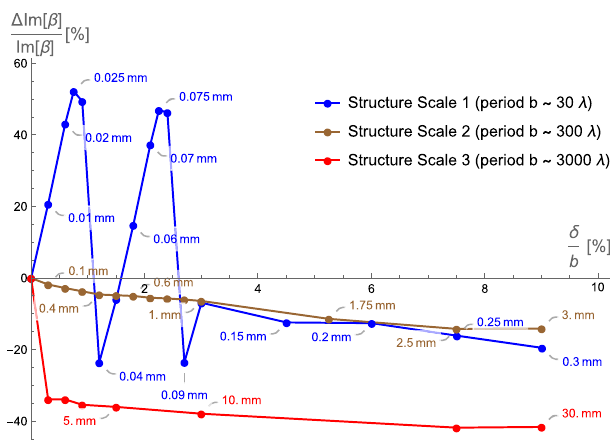
FIG. 8. Effect of varying screen thickness δ from zero to ∼ b= 10 on Im ½ β 0 (cid:2) , for the three scales discussed above, shown together on the same figure for comparison. Selected points on the curve give explicit value of δ in mm. See data in Table II for details.